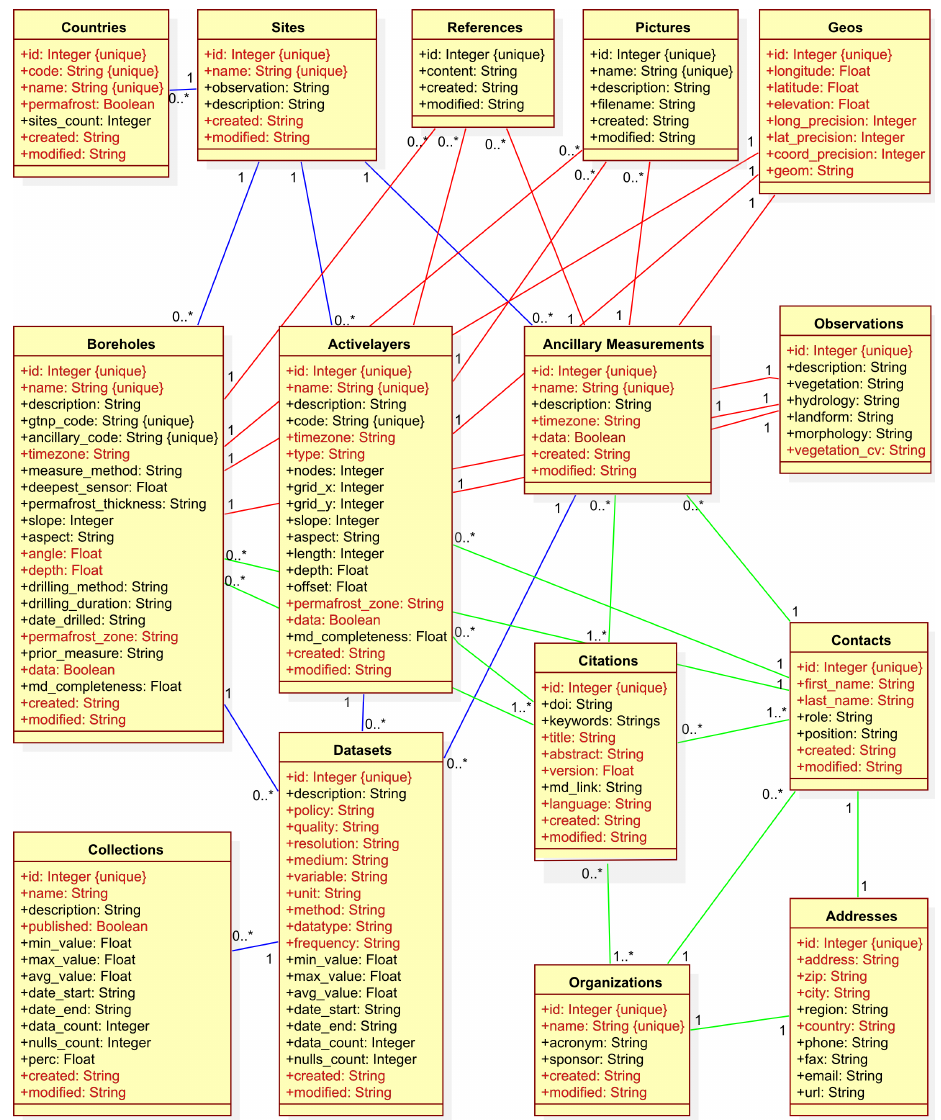
Figure 2. UML (Unified Modeling Language) diagram of the object-oriented GTN-P Data Management System and its classes, cardinalities and metadata (mandatory metadata in